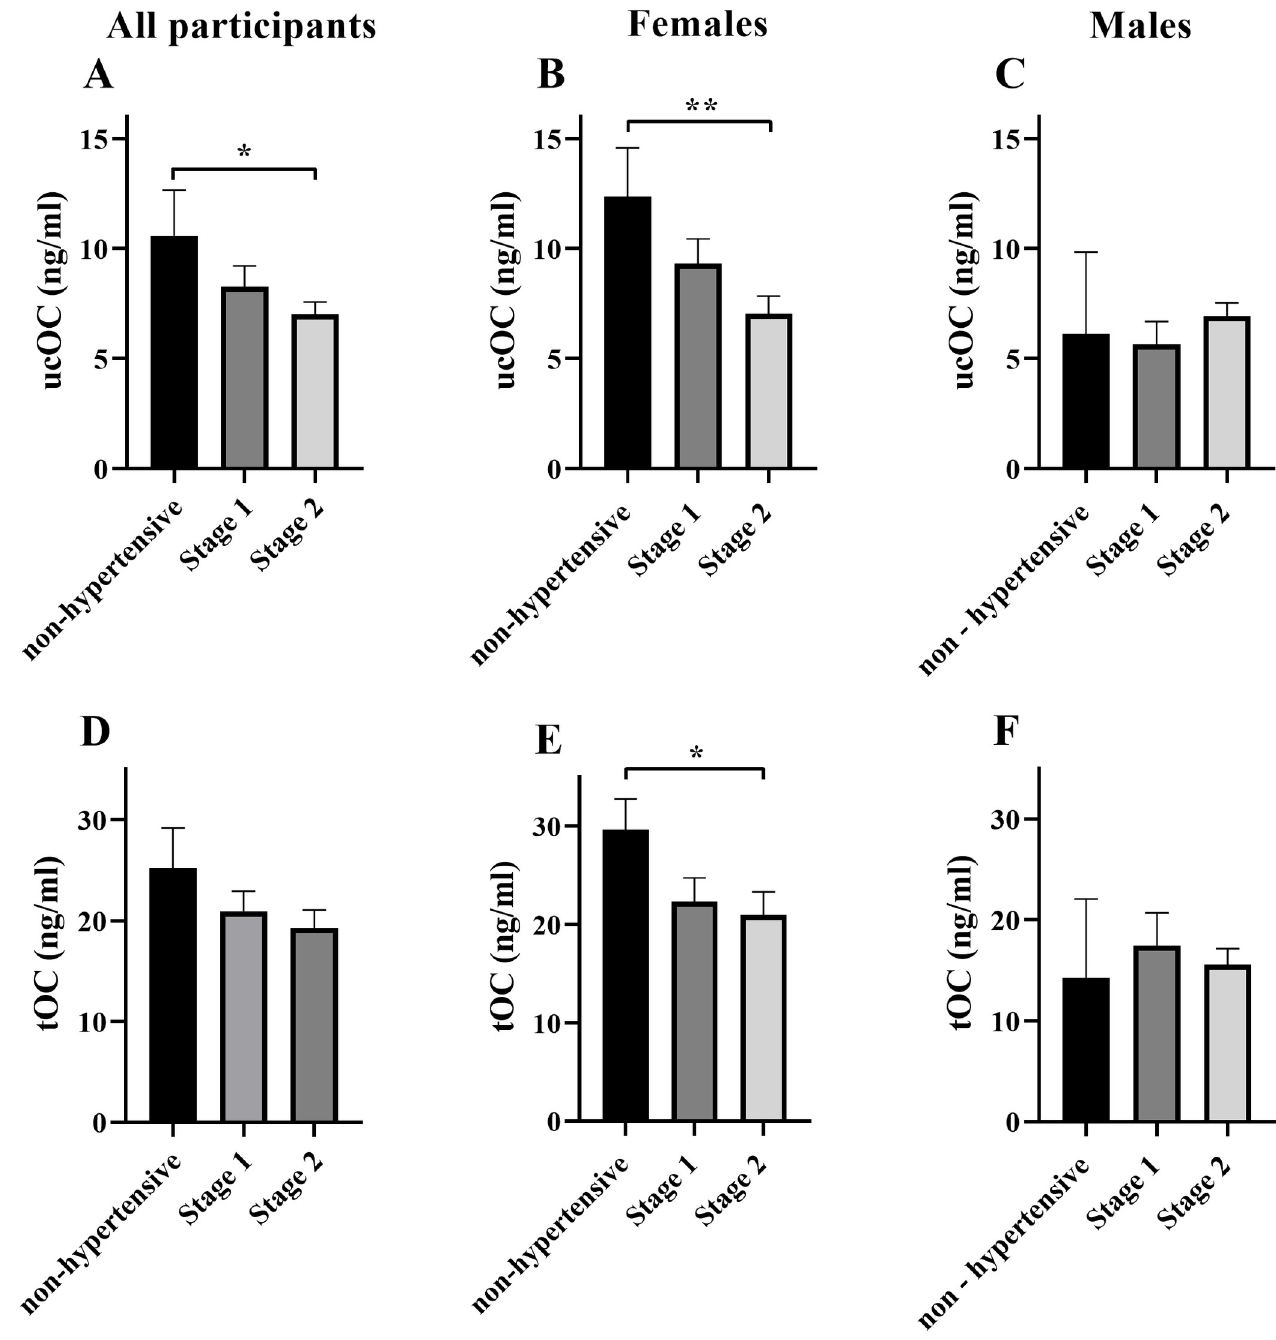
Fig 1. Concentration of ucOC and tOC based on hypertension category. ucOC concentration in all participants (A), women (B) and men (C) and tOC concentration in all participants (D), women (E) and men (F) split into groups based hypertension category; non-hypertensive ( < 130/ < 80mm/Hg) (women n = 5, men n = 2), stage 1 hypertension (130-139/80-89mm/Hg) (women n = 10, men n = 4) and stage 2 hypertension ( > 140/ > 90mm/Hg) (women n = 11, men n = 6). Given the small sample size in each group, particularly for males, the data are not conclusive and further examination of sex specific effects should be explored. All data mean ± SEM. � p < 0.05, �� p < 0.01 between groups. Abbreviations : ucOC; undercarboxylated osteocalcin , tOC; total osteocalcin .